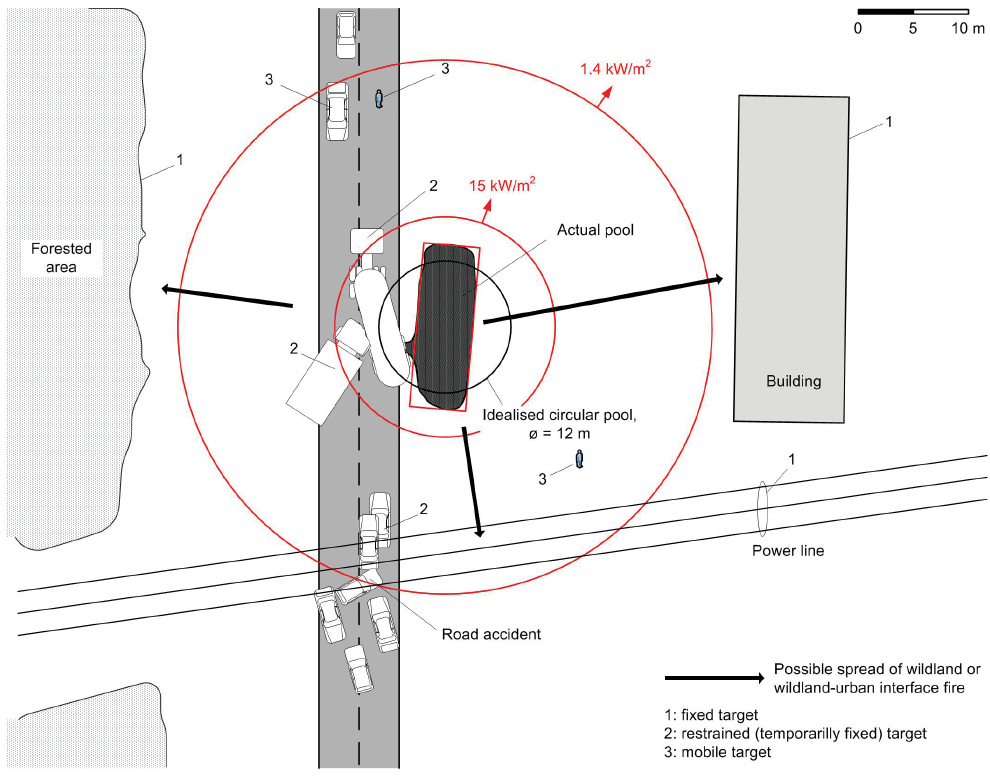
Figure 1. An illustration of an accident caused by release and ignition of flammable liquid shipped by a tanker truck (the thermal radiations of 1.4 kW/m 2 and 15 kW/m 2 are approximate values obtained for a gasoline pool by means of a point source model (Beyler,